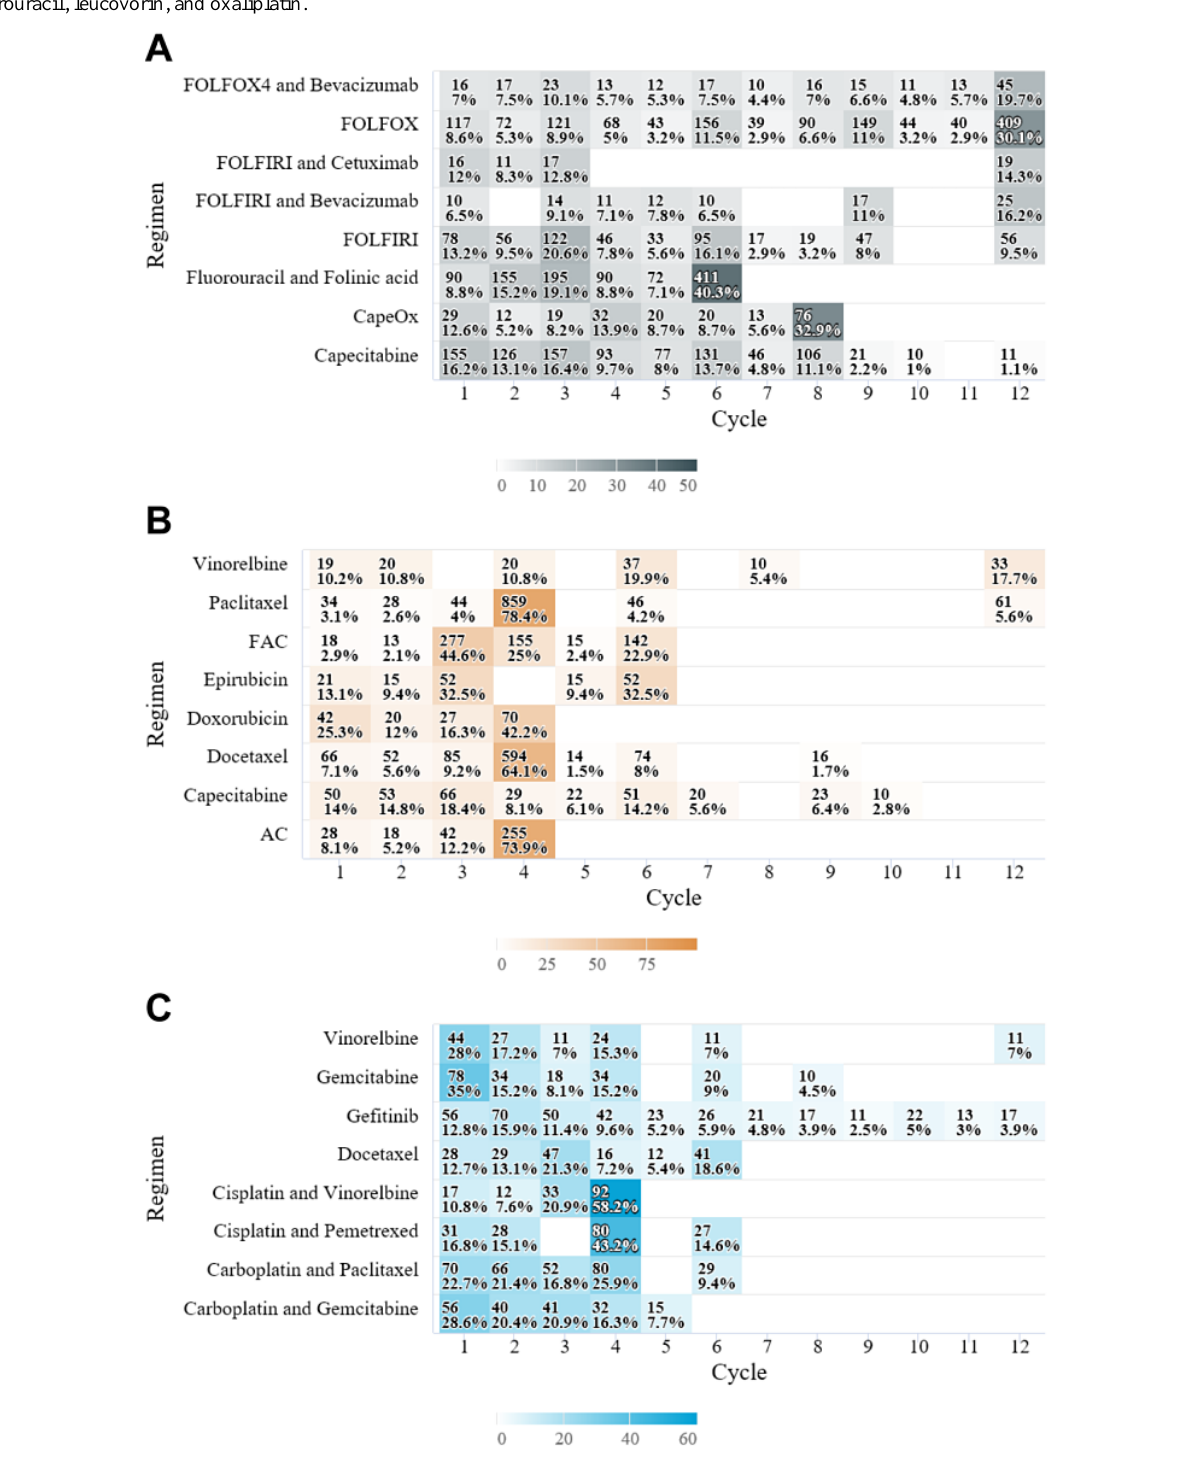
Figure 4. Heat map of patient distribution for cycle iteration by regimen type in the Ajou University School of Medicine database. The number of patients with (A) colorectal cancer, (B) breast cancer, and (C) lung cancer is shown; treatment iteration count is represented by color saturation, with a darker shade representing a higher number of patients. Cells with <10 patients are not reported. AC: doxorubicin and cyclophosphamide; CapeOx: capecitabine and oxaliplatin; FAC: fluorouracil, doxorubicin, and cyclophosphamide; FOLFIRI: fluorouracil, leucovorin, and irinotecan; FOLFOX: fluorouracil, leucovorin, and